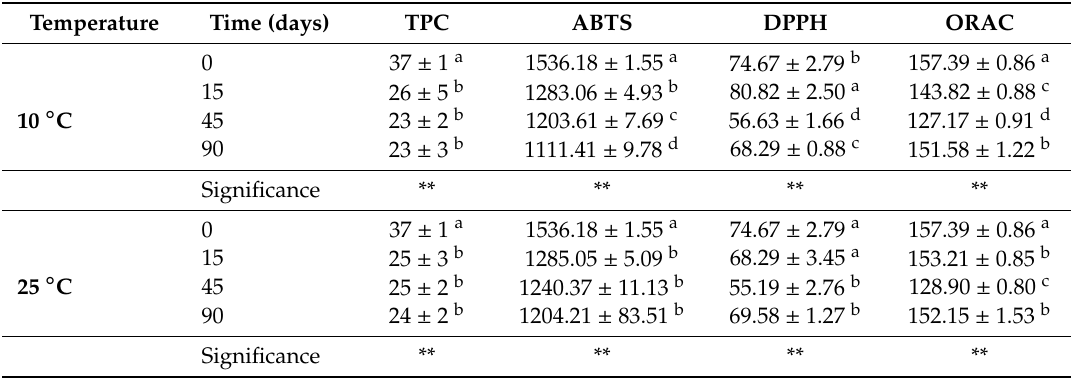
Table 5. TPC (mgGA 100 g − 1 ) and total antioxidant activity by ABTS, DPPH and ORAC assays ( µ mol TE 100 g − 1 ) of the samples stored at di ff erent temperatures.